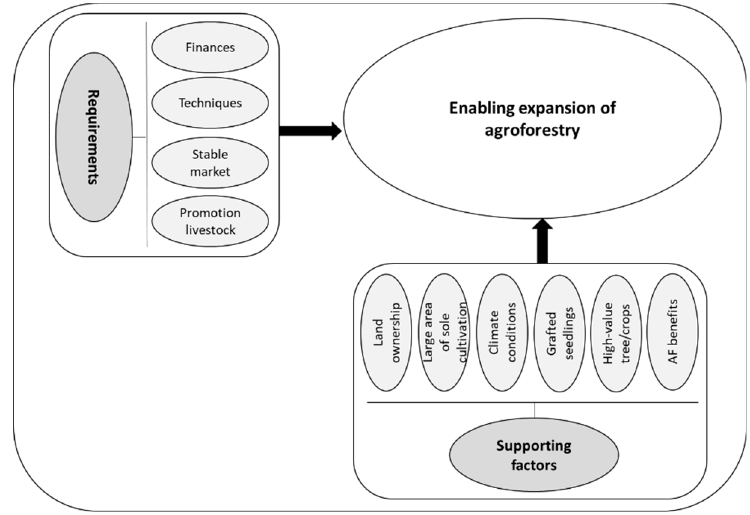
Figure 10. Farmers’ perspectives about factors enabling expansion of agroforestry in Van Chan and Tuan Giao.